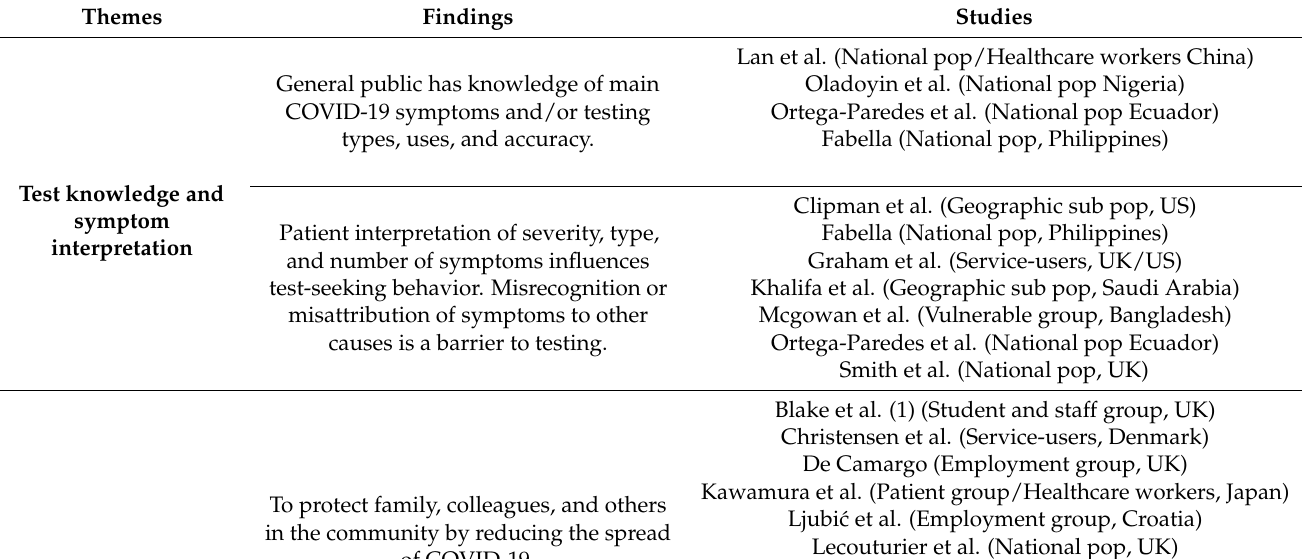
Table 2. Acceptability, uptake, and barriers to